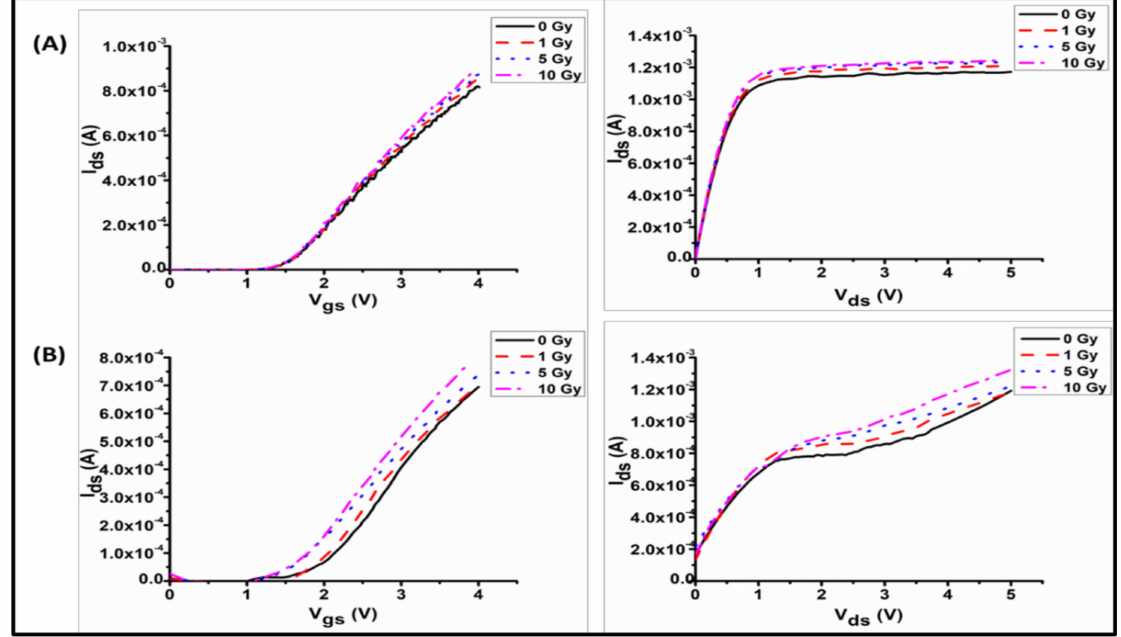
Figure 7. ( A ) Linear and saturation regime for the thin film and ( B ) linear and saturation regime for the 1 mm disk ZnO-Pb, under high absorbed